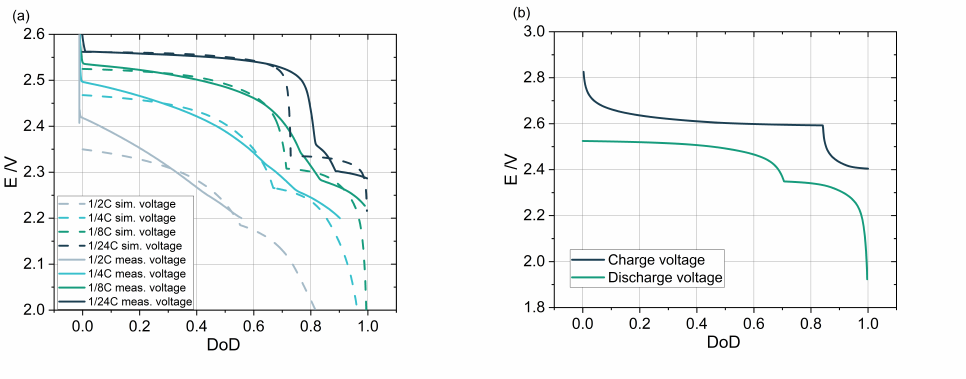
Figure 5. ( a ) Simulated and measured discharge voltages for four different C-rates over DoD. ( b ) Modelled charge and discharged voltage for 1/8C showing a